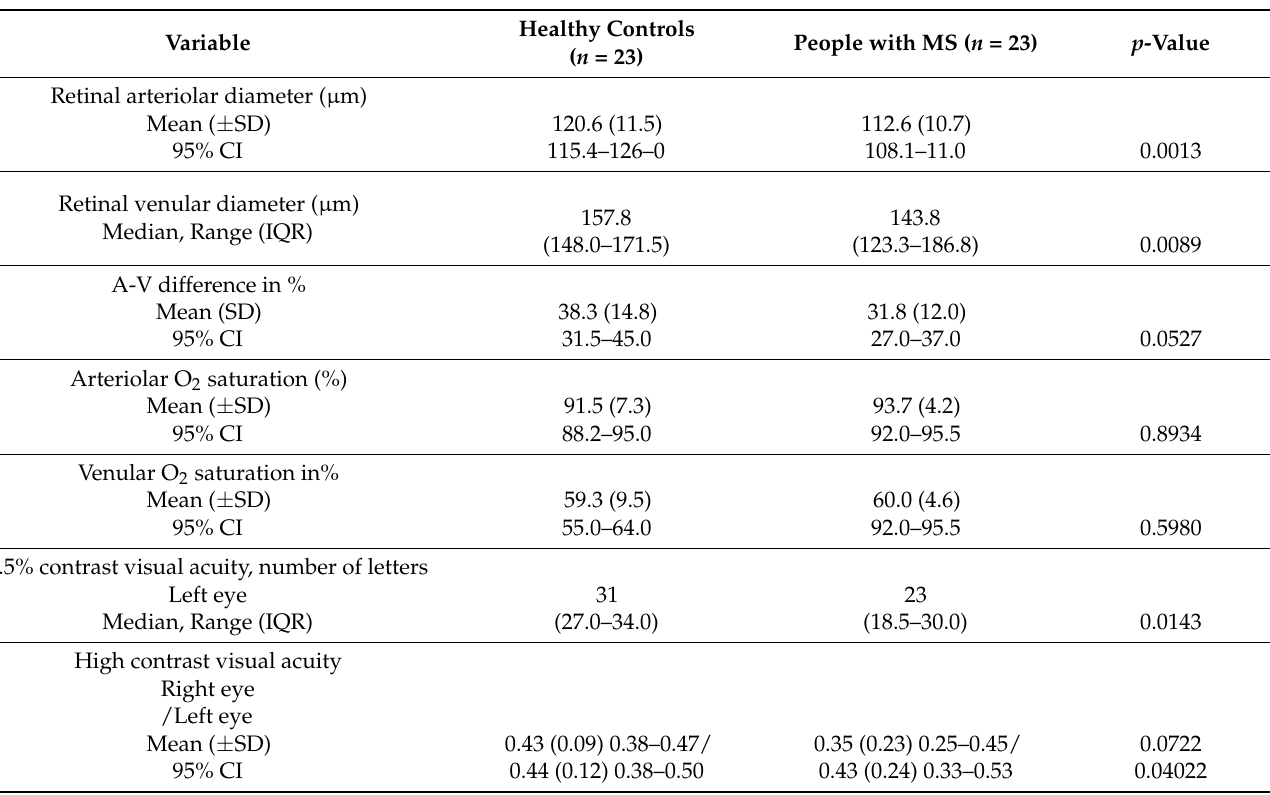
Table 2. Vessel diameters, oxygen saturation, and 2.5% contrast visual acuity in the healthy controls and people with